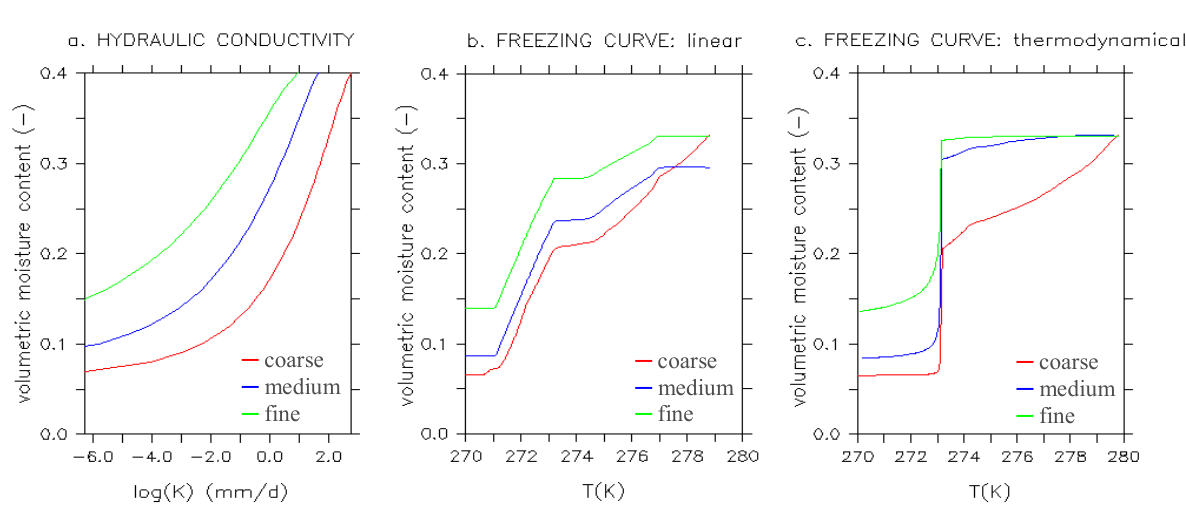
Fig. 1. (a) Hydraulic conductivities of the three soil types (fine, medium, coarse) represented in ORCHIDEE. (b) Liquid water content as a function of temperature as simulated with the linear freezing for those three soil types. Initial soil volumetric moisture content and temperature were 0.33 and 280K. (c) Same as (b) but for the thermodynamical